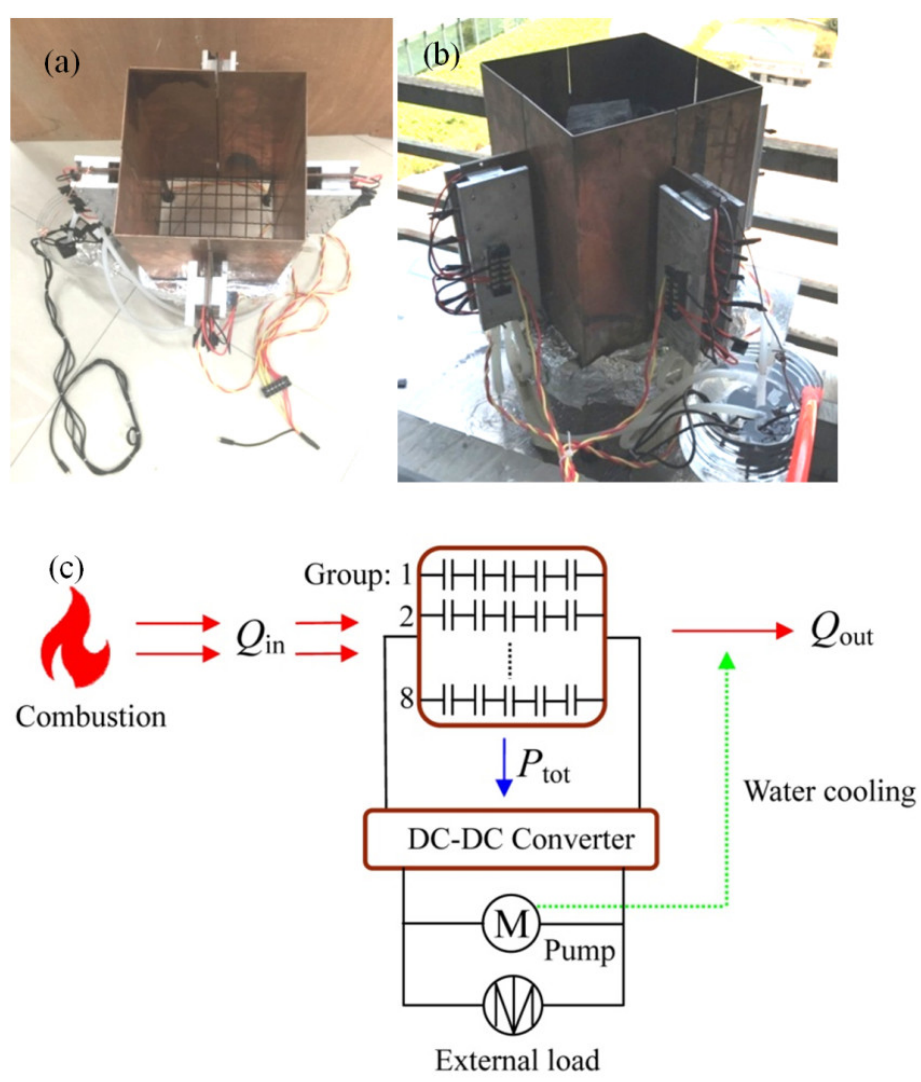
Table 2. TE properties of SAGREON 12708.